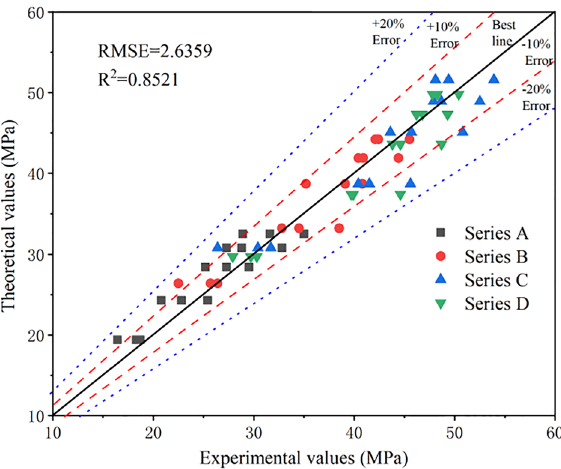
Figure 8. Comparison between theoretical and experimental results for compressive strength of